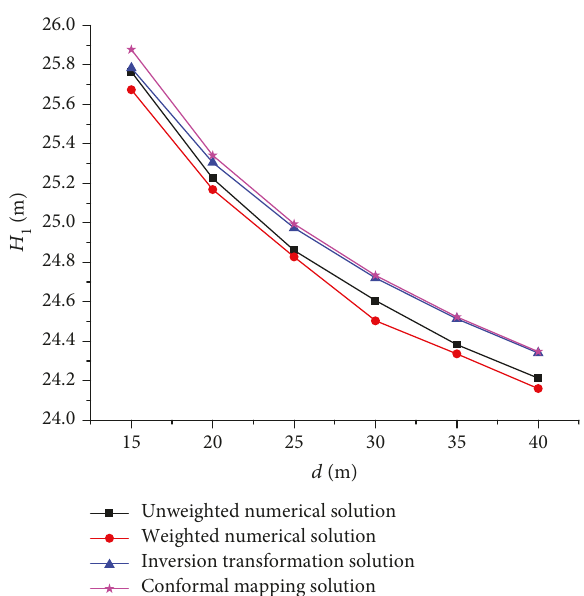
Figure 8: Relationship between the head pressure and distance.